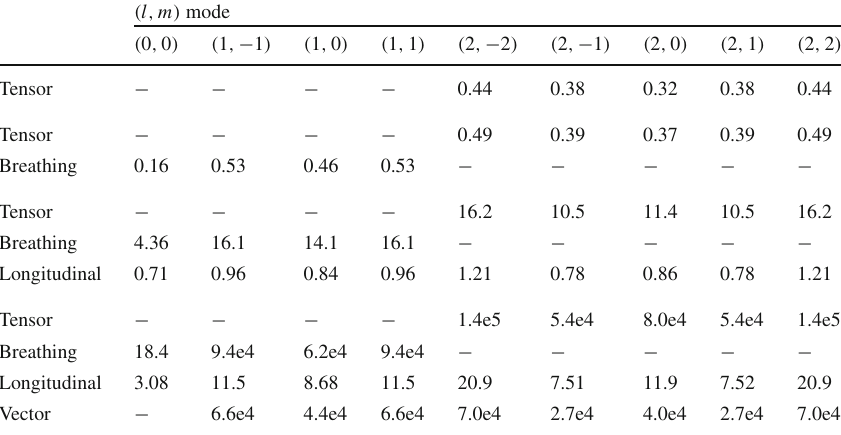
Table 7 Relative uncertainties for the tensor, breathing, scalar-longitudinal, and vector-longitudinal polar- ization modes searched for separately or in various combinations for l max = 2 and N p = 30